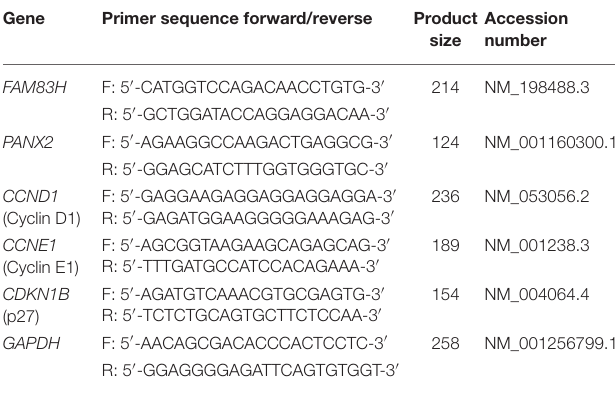
TABLE 1 | Primer sequences used for quantitative real-time polymerase chain